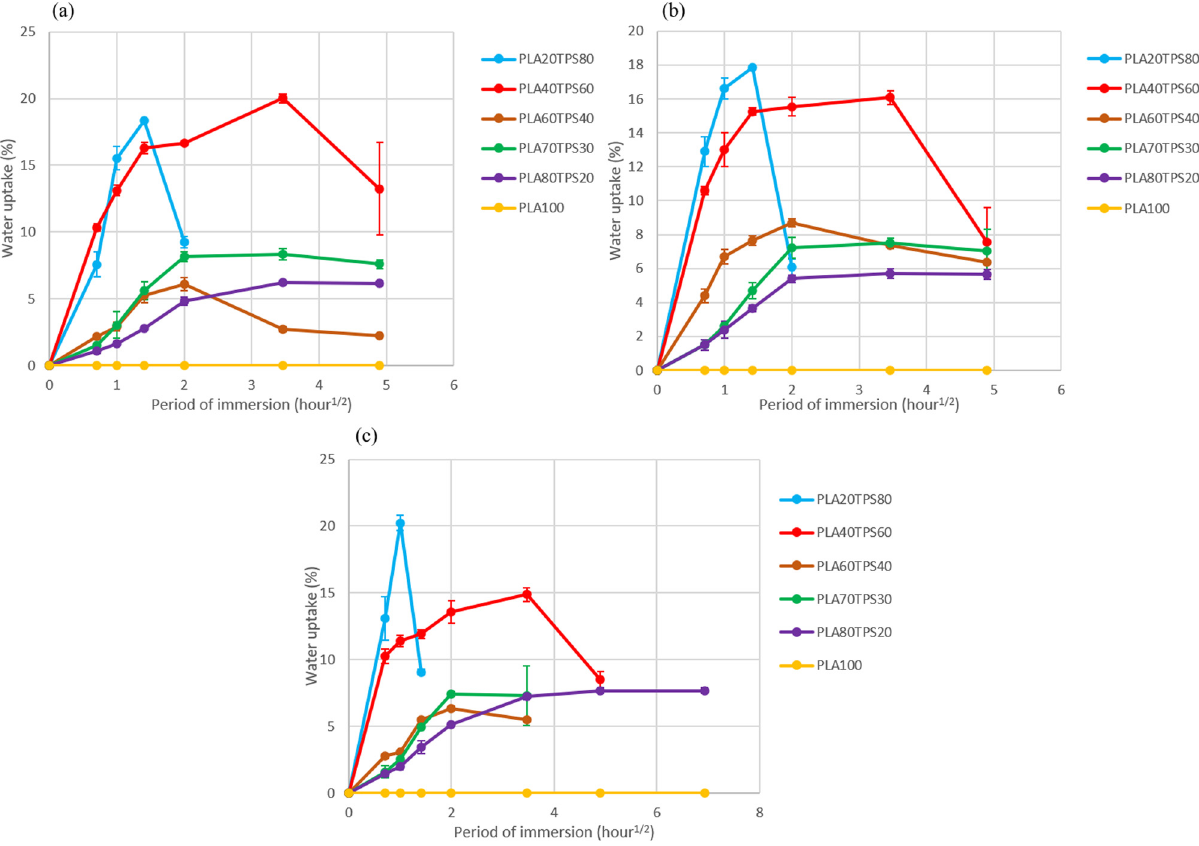
Figure 4: The water uptake ( % ) against period of immersion ( hour 1/2 ) of PLA100 and PLA/TPS blend bionanocomposites within: ( a ) seawater, ( b ) river water, and ( c ) sewer